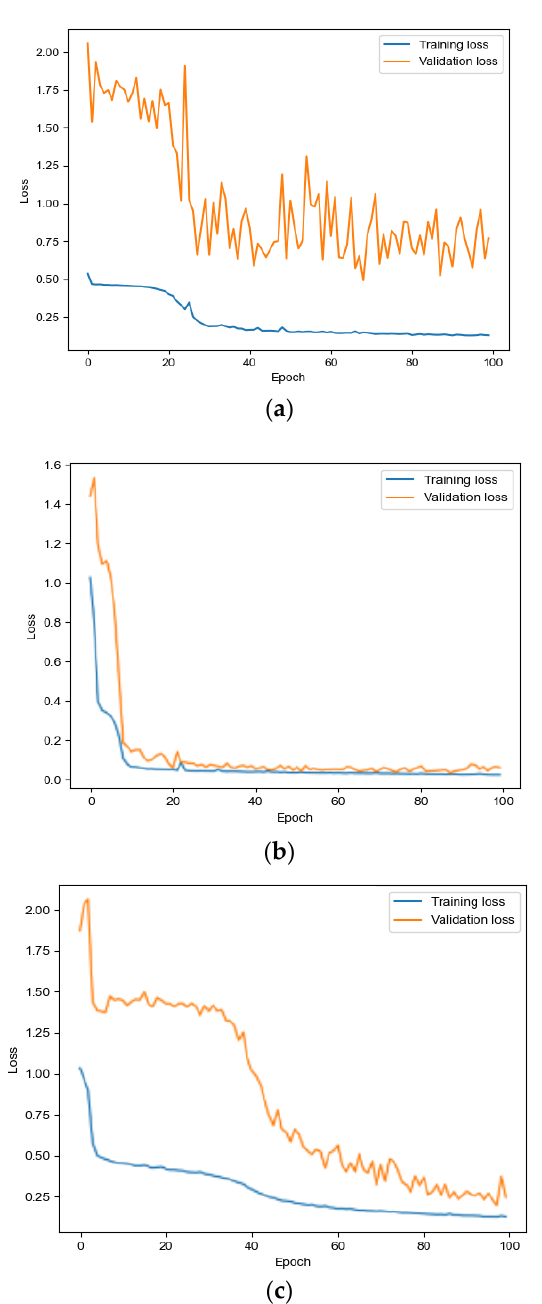
Figure 5. Training/validation loss per epoch using the GRU-based variant for time slice classification on: ( a ) UAH, ( b ) MOTIF 1 and ( c ) MOTIF 2 datasets. Table 4. Confusion matrices for time slice classification.